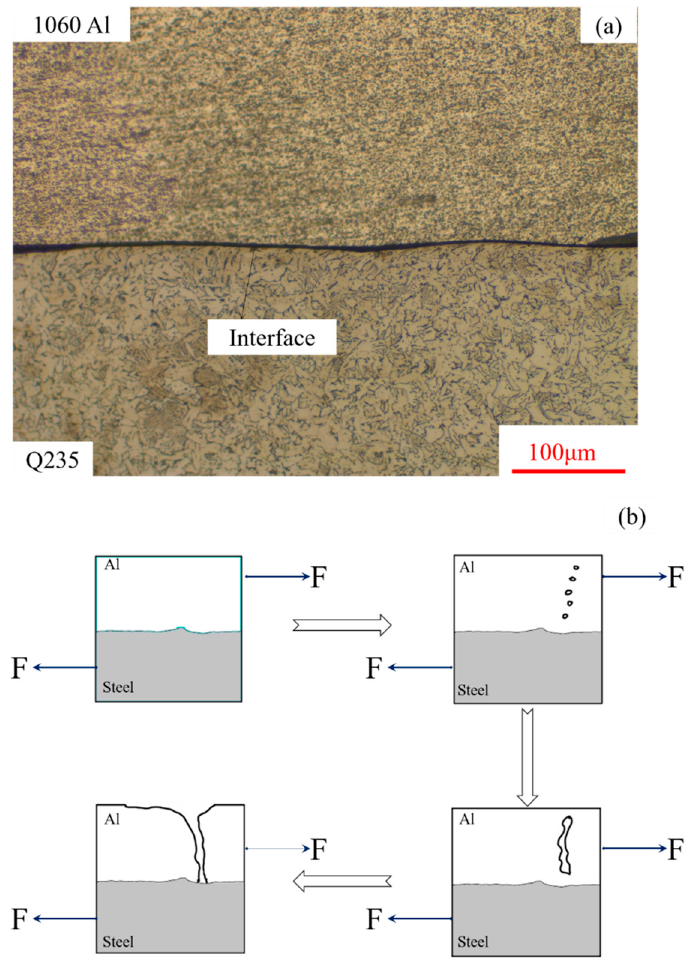
Figure 14. Failure mechanism of thin and flat interface: ( a ) physical diagram; ( b ) failure diagram of flat interface.